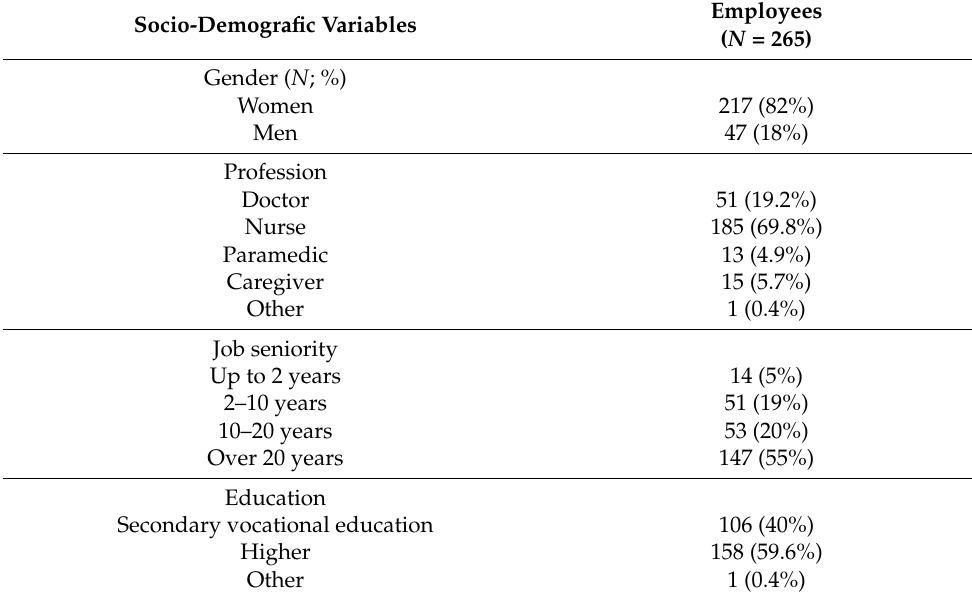
Table 1. Socio-demographic characteristics of the study